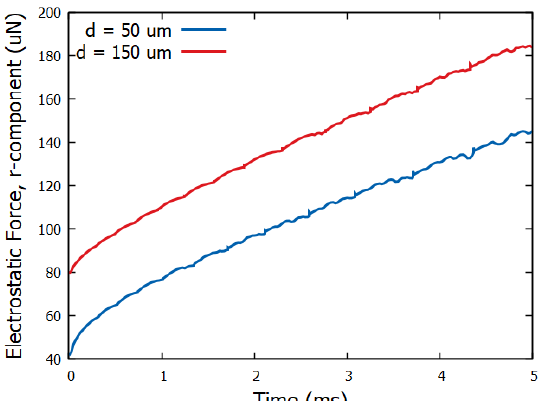
Figure 6. Effective electrostatic force in the radial direction, F el distributions for the thin ( d = 50 µ m) and the thick ( d = 150 µ m) dielectric cases ( η =